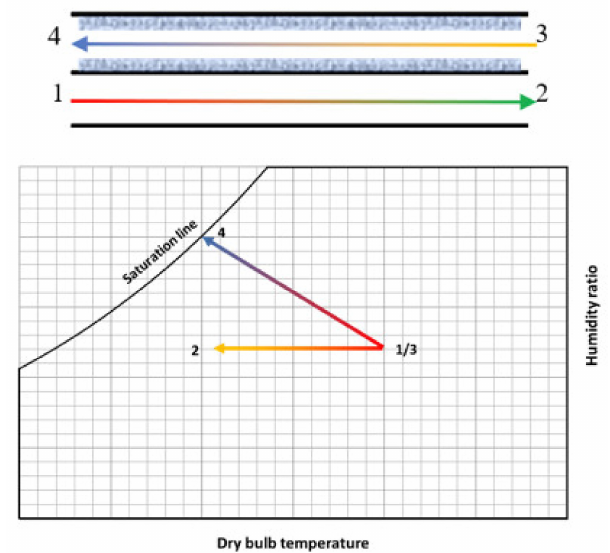
Figure 1. Working principle of IEC and its psychrometric chart